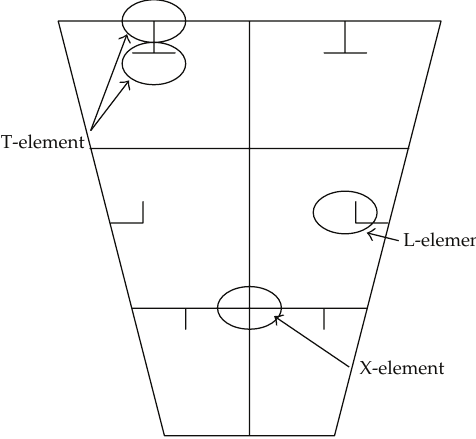
Figure 6: Description of basic elements of a ship